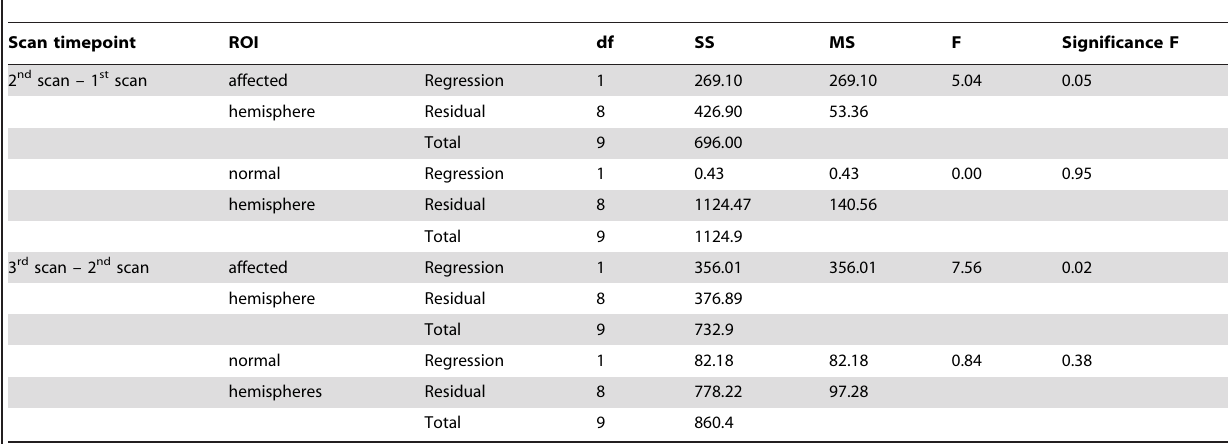
Table 2. ANOVA test results of four regression models for both hemispheres.